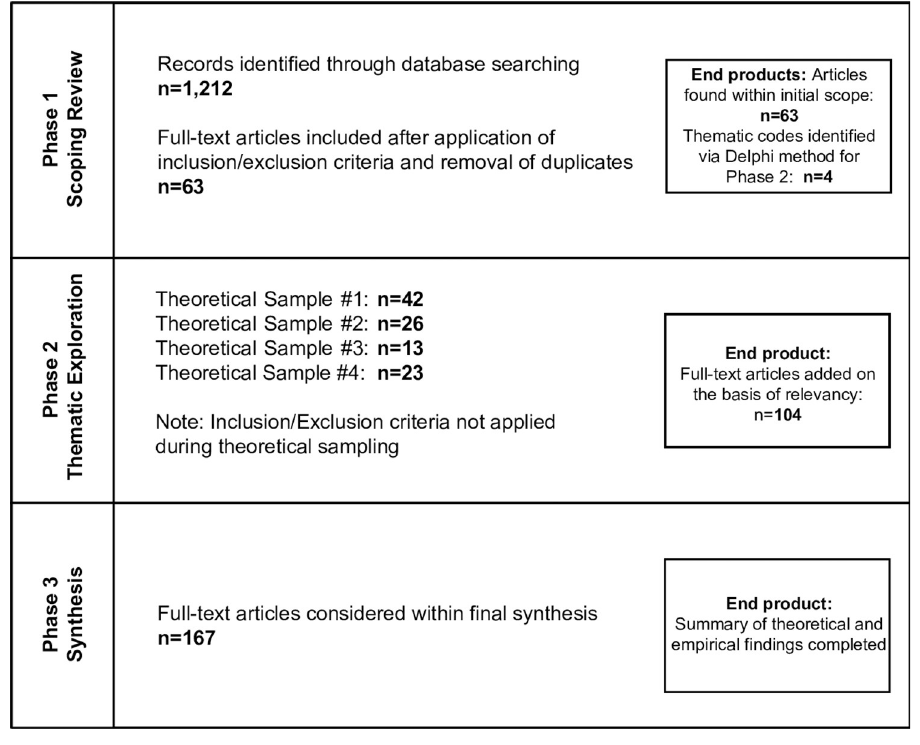
Fig 1. Summary of review